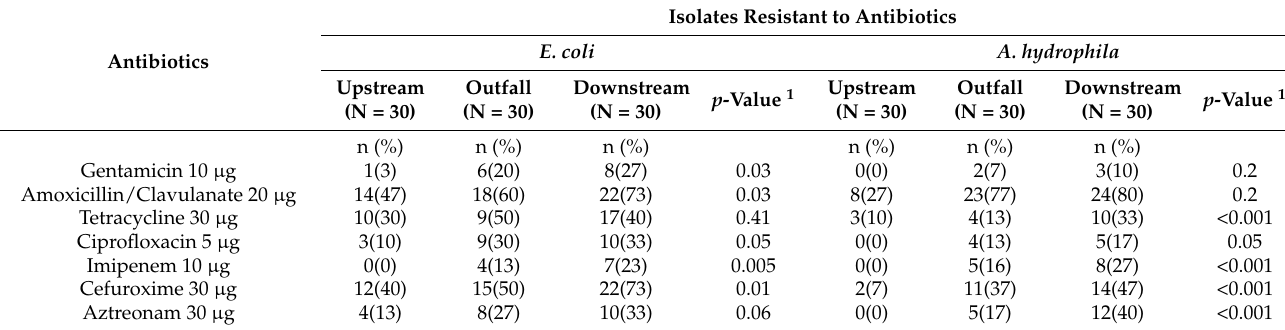
Table 6. Antibiotic resistance profiles of P. aeruginosa isolates in upstream, outfall, and downstream of the Onyasia stream, Accra, Ghana (January to June 2018). Isolates Resistant to Antibiotics P. aeruginosa Antibiotics Upstream (N = 30) Outfall (N = 30) Downstream (N = 30) p -Value Gentamicin 10 µ g